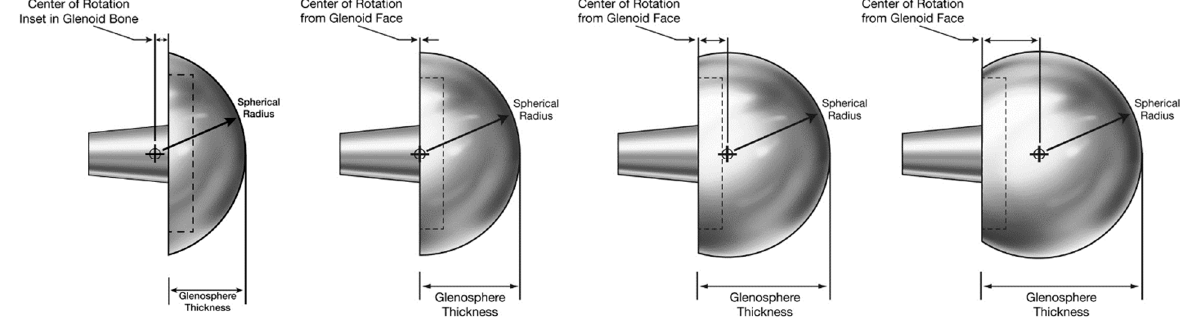
Figure 6. rTSA glenoid prosthesis design classification, representative images of four glenosphere designs having equivalent articular curvatures, demonstrating that the relationship between glenoid thickness and articular radius is directly related to the lateralization of the CoR relative to the glenoid fossa.